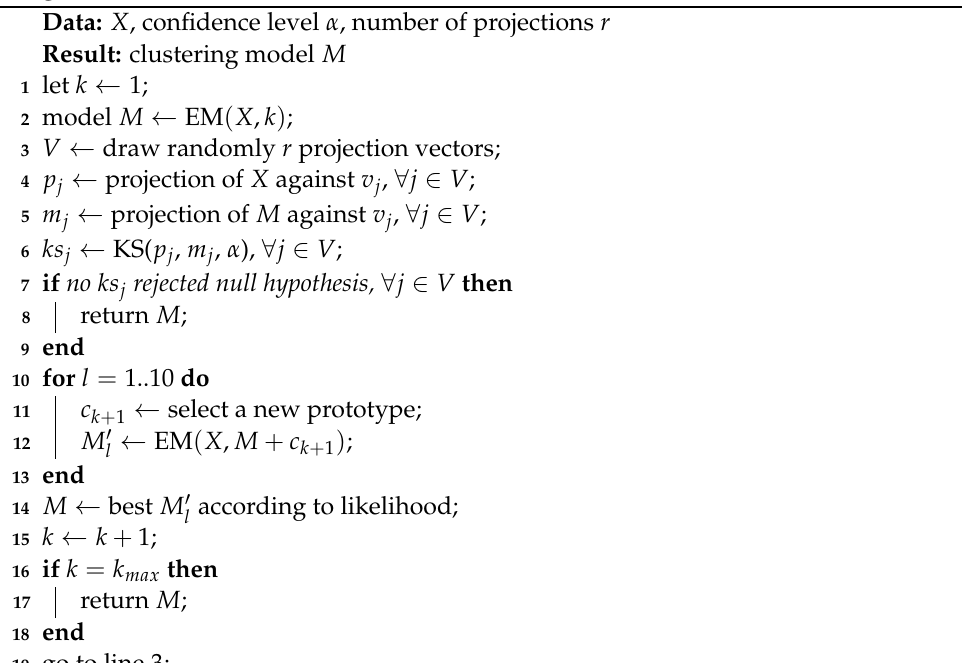
Algorithm 2: SPG-means overview Data: X , confidence level α , number of projections